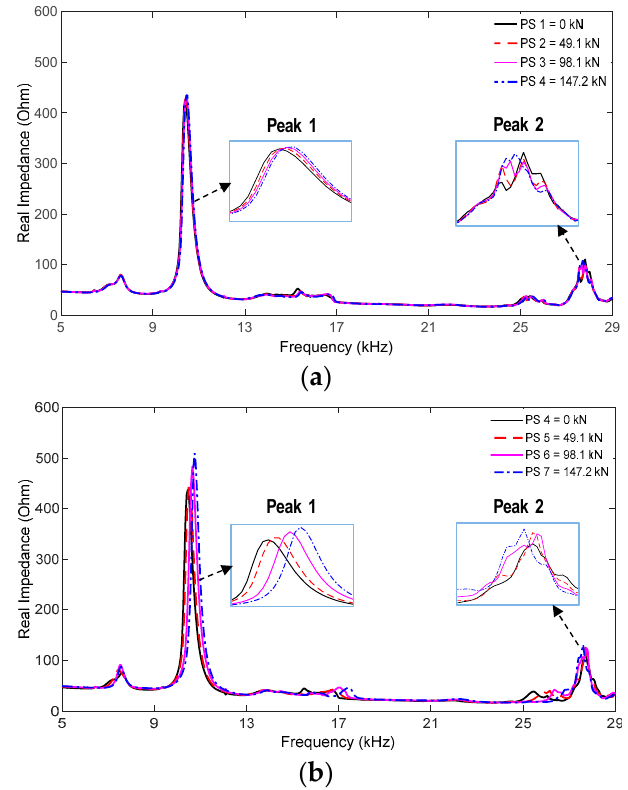
Figure 20. Impedance responses of the hoop PZT interface under prestressing cases. ( a ) Prestressing cases of Strand 9: PS1–PS4 and ( b ) prestressing cases of Strand 1: PS4–PS7.